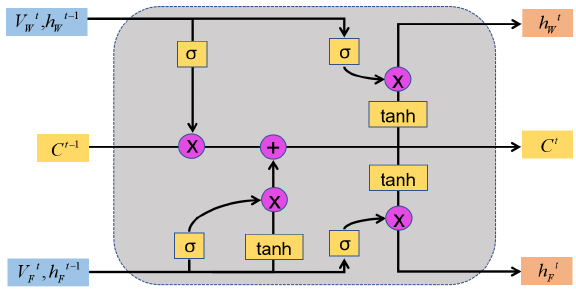
Figure 7. The neuron unit structure of